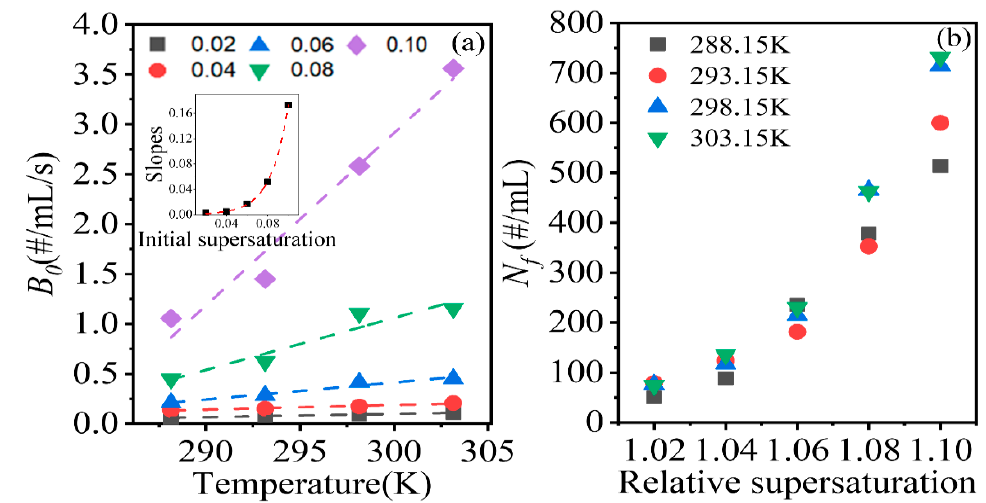
Figure 5. Secondary nucleation rate B 0 ( a ) and final crystal suspension density Nf ( b ) at different supersaturation levels and temperatures.